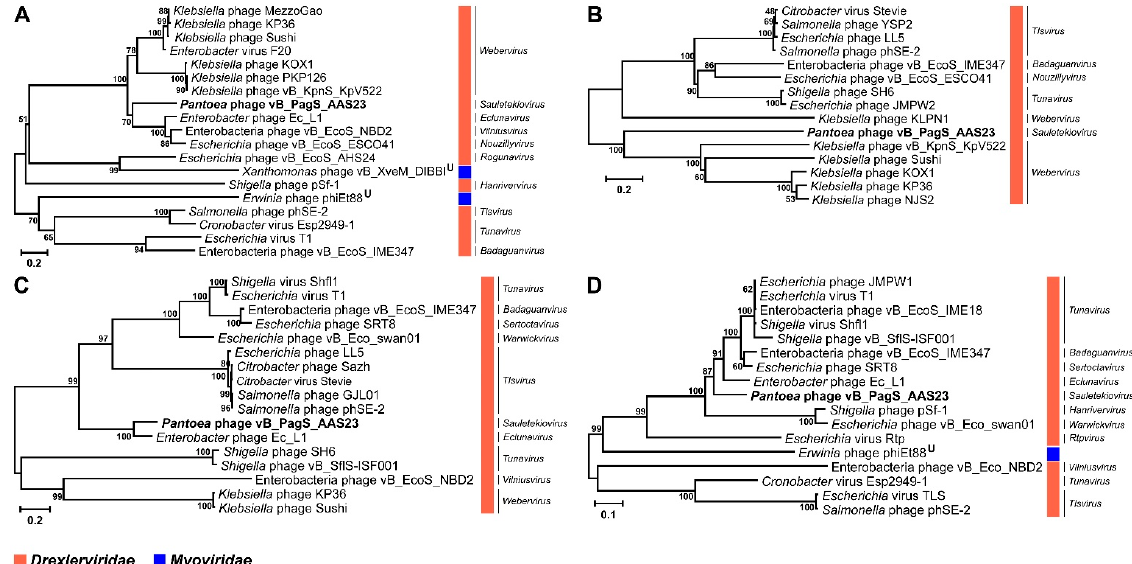
Figure 4. Neighbor-joining tree analysis based on the alignment of the amino acid sequences of Pantoea phage vB_PagS_AAS23: ( A ) major capsid protein, ( B ) tape measure protein (TMP), ( C ) helicase, and ( D ) terminase large subunit (terL). The percentage of replicate trees in which the associated taxa clustered together in the bootstrap test is shown next to the branches.